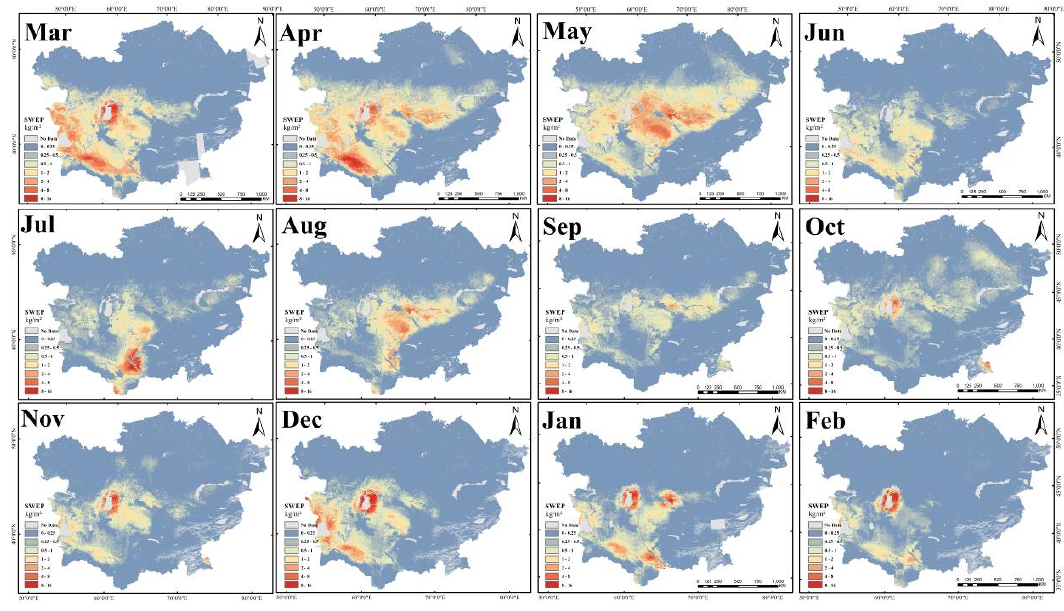
Figure 7. The monthly average variation of SWEP during the period of 2000–2019.